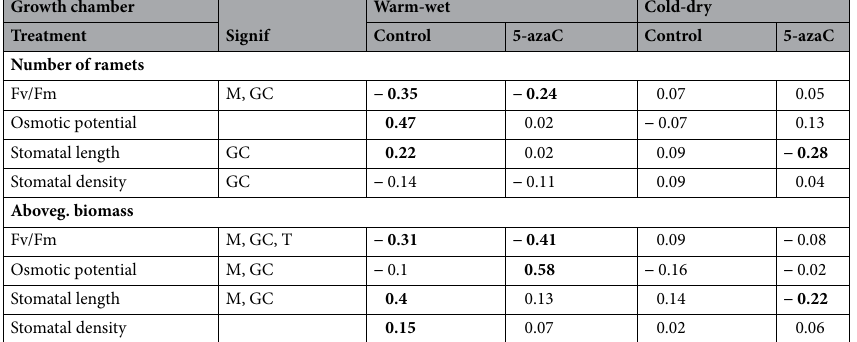
Table 3. Relationships between ecophysiological and fitness-related traits in control plants and plants treated with 5-azaC growing in two different environments in growth chambers (warm-wet and cold-dry). The table shows standardized linear selection gradients (β) estimated as the multiple regression coefficients of relative fitness (i.e. standardized ramet number and aboveground biomass) on standardized mean trait values (ecophysiological traits). Significant β values (p ≤ 0.05) are marked in bold. F v /F m —maximum photosystem II efficiency. Column signif. indicates significant main effect of the trait (M), interaction between the trait and growth chamber (GC), 5-azaC treatment (T) or their interaction (GC × T) when analyzing all the data within a single